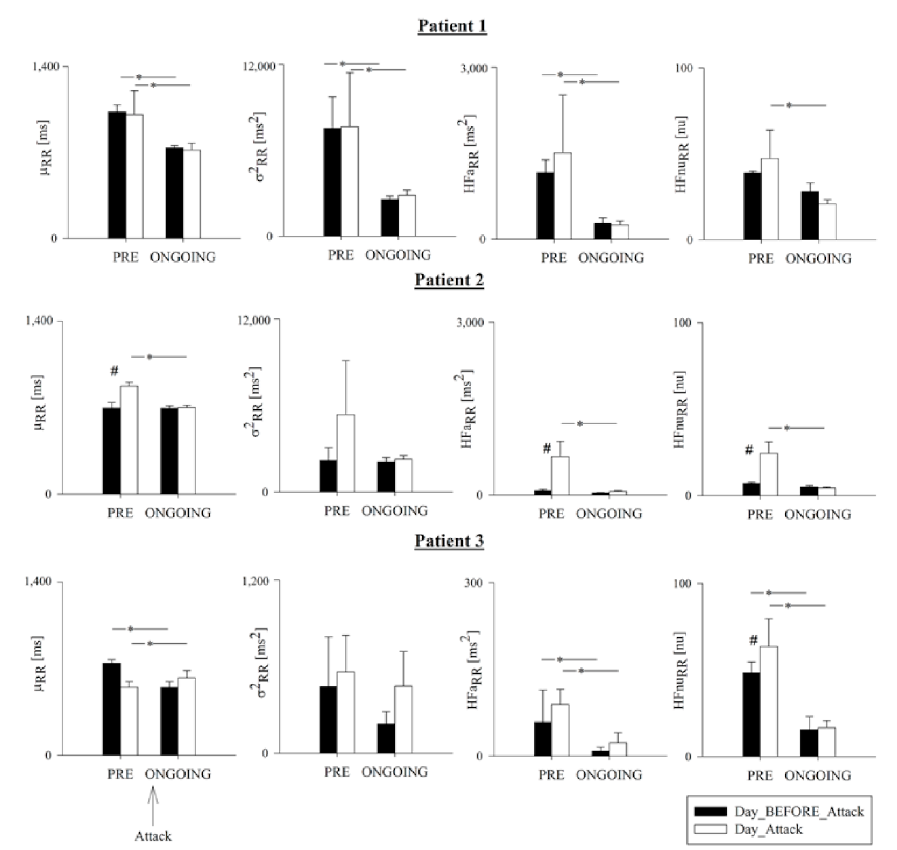
Figure 2. Pooled time- and frequency-domain HRV markers in Patients 1, 2 and 3. Bar graphs show RR mean ( µ RR ), RR variance ( σ 2 RR ), and absolute (HFa RR ) and normalized (HFnu RR ) power in the HF band. Hour-by-hour data in the 4 h preceding (PRE) and in the first 4 h following the onset of the HAE attack (ONGOING) were pooled together on the day of the attack (Day_Attack, white bars) and compared with data during the same phase of the circadian rhythm on the day before (Day_BEFORE_Attack, black bars). Data pertain to Patient 1 (upper panels), Patient 2 (middle panels), and Patient 3 (lower panels), and are presented as mean ± standard deviation. Symbol # indicates p < 0.05 Day_Attack vs. Day_BEFORE_Attack and the symbol * indicates p < 0.05 PRE vs.